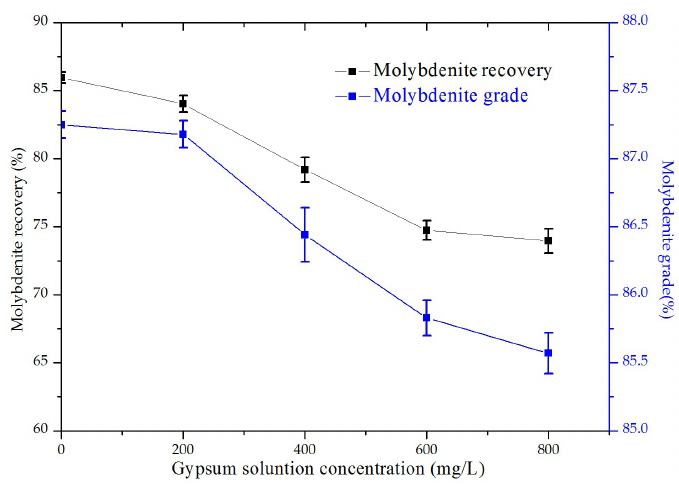
Figure 5. Molybdenite recovery and grade varied as gypsum solution concentration.